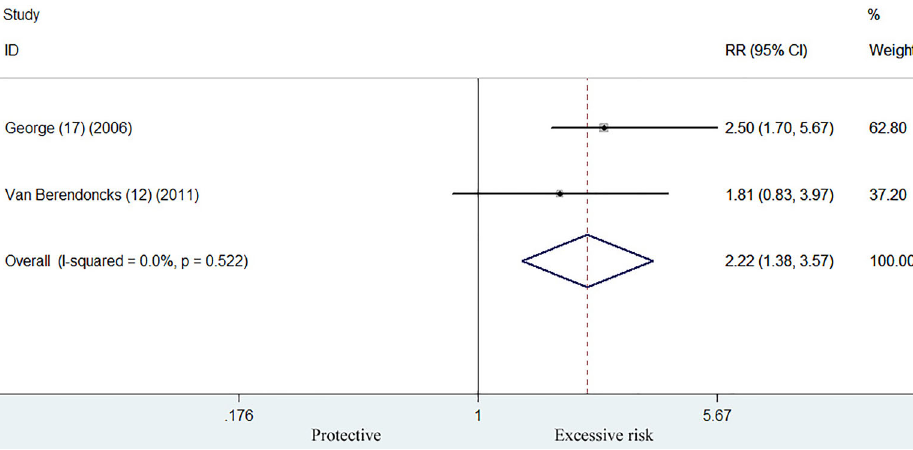
Figure 3. Forest plot showing risk ratio with 95%CI of combined end points of death/readmission for the higher versus lower category of adiponectin level in a fi xed-effect